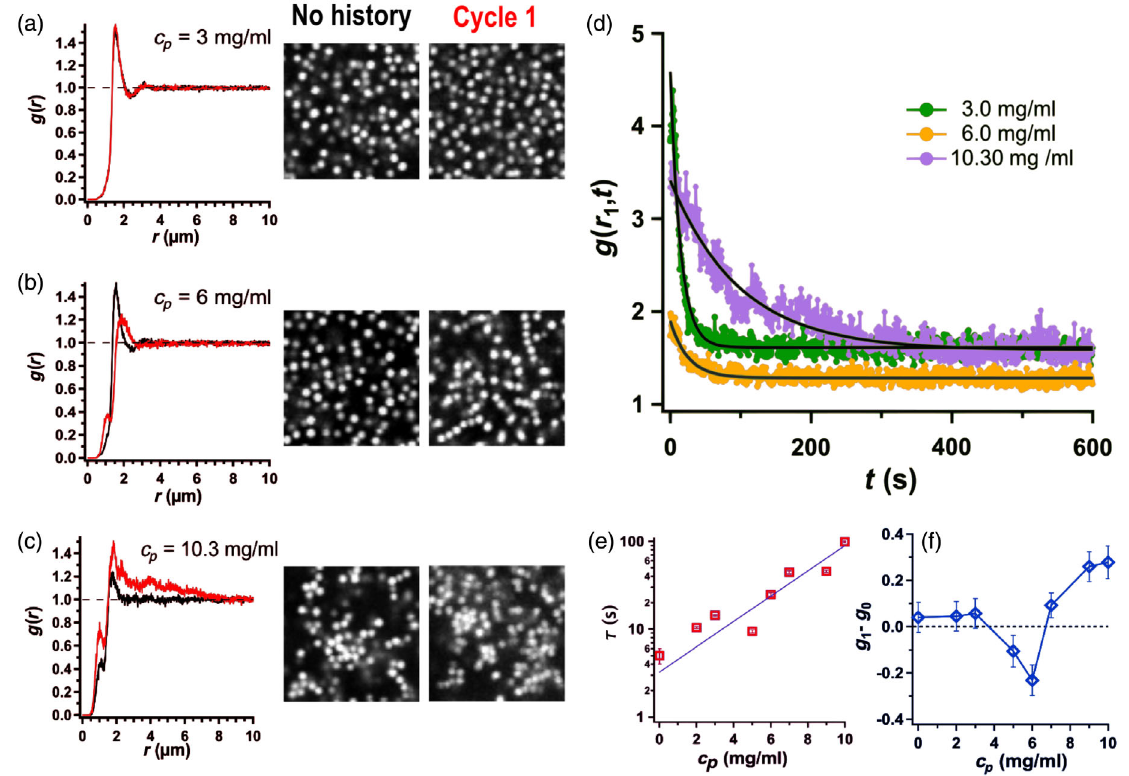
FIG. 4. Reversibility in the dipolar-depletion phase diagram. (a) – (c) Comparison of the radial distribution function g ð r Þ and ¼ 3 mg = ml, (b) 6 mg = ml, and representative snapshots, with no history and after one cycle of turning the field on and off at (a) c p (c) 10 . 3 mg = ml. The black g ð r Þ curve denotes no history of electric field in the sample, i.e., before the field is applied, while the red g ð r Þ curve is cycle 1 (field off). 2D images ( 64 × 64 pixels) corresponding to the graphs are captured before turning on the field (no history) ¼ 3 , 6, and 10 . 3 mg = ml after field is turned off is and after turning off the field (cycle 1). (d) Structural relaxation kinetics g ð r 1 ; t Þ at c p well fit to an exponential decay with time constant τ . (e) The characteristic decay time ( τ ) taken by colloidal structures to disintegrate and reach a steady state increases exponentially with c . (f) Comparing g ð r Þ (no history) with its value after cycle 1, i.e., g 1 − g 0 , provides a p quantitative measure of reversibility: g 1 − g 0 is zero (reversible) in the DIO regime, but nonzero at higher c . p